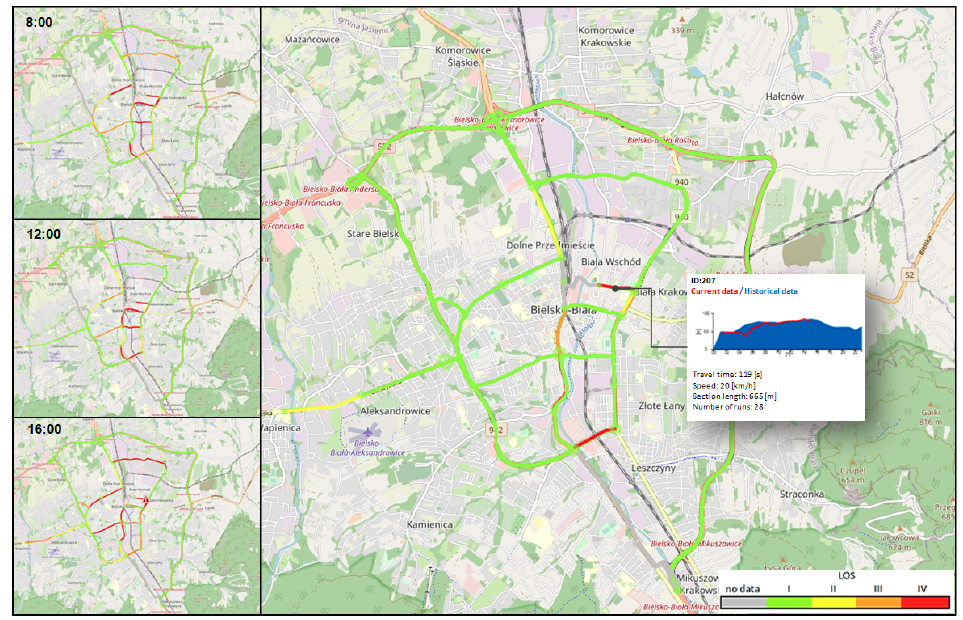
Figure 3. A sample graphic interface of the OnDynamic system. Map source: